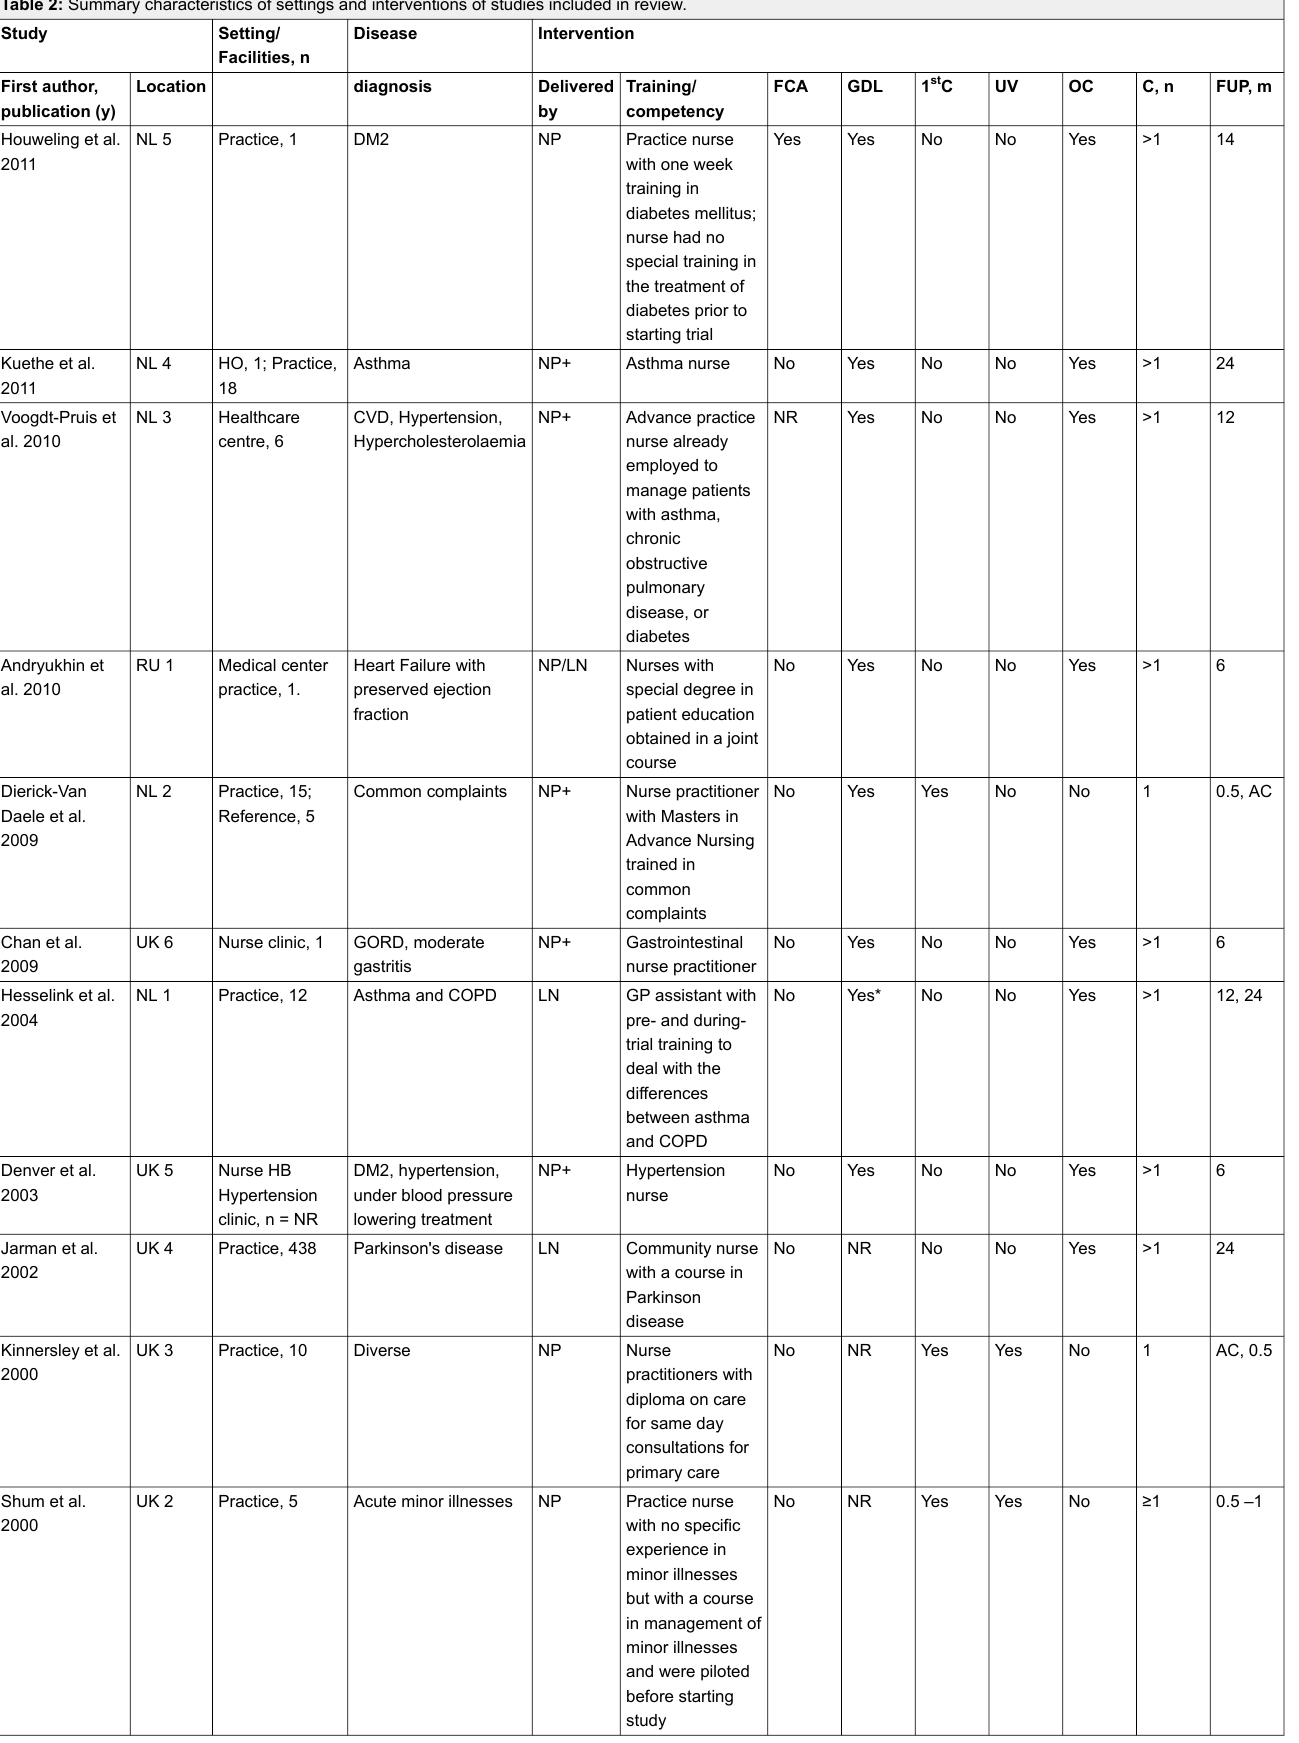
Table 2: Summary characteristics of settings and interventions of studies included in